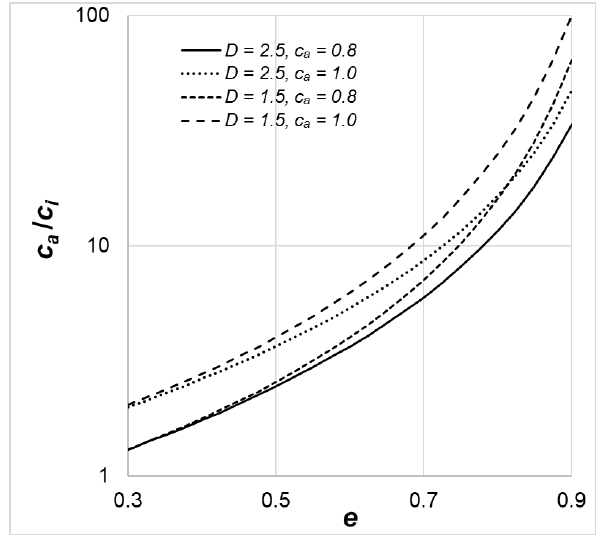
Figure 2. The ratio of maximum solid volumetric fraction c a over minimum solid volumetric fraction c i ( c a / c i ) of the truncated power-law distribution in relation to the porosity and fractal parameters. The influence of porosity on the dimensionless permeability, with a few selected values of the fractal parameters, is shown in Figure 3. When the heterogeneous solid